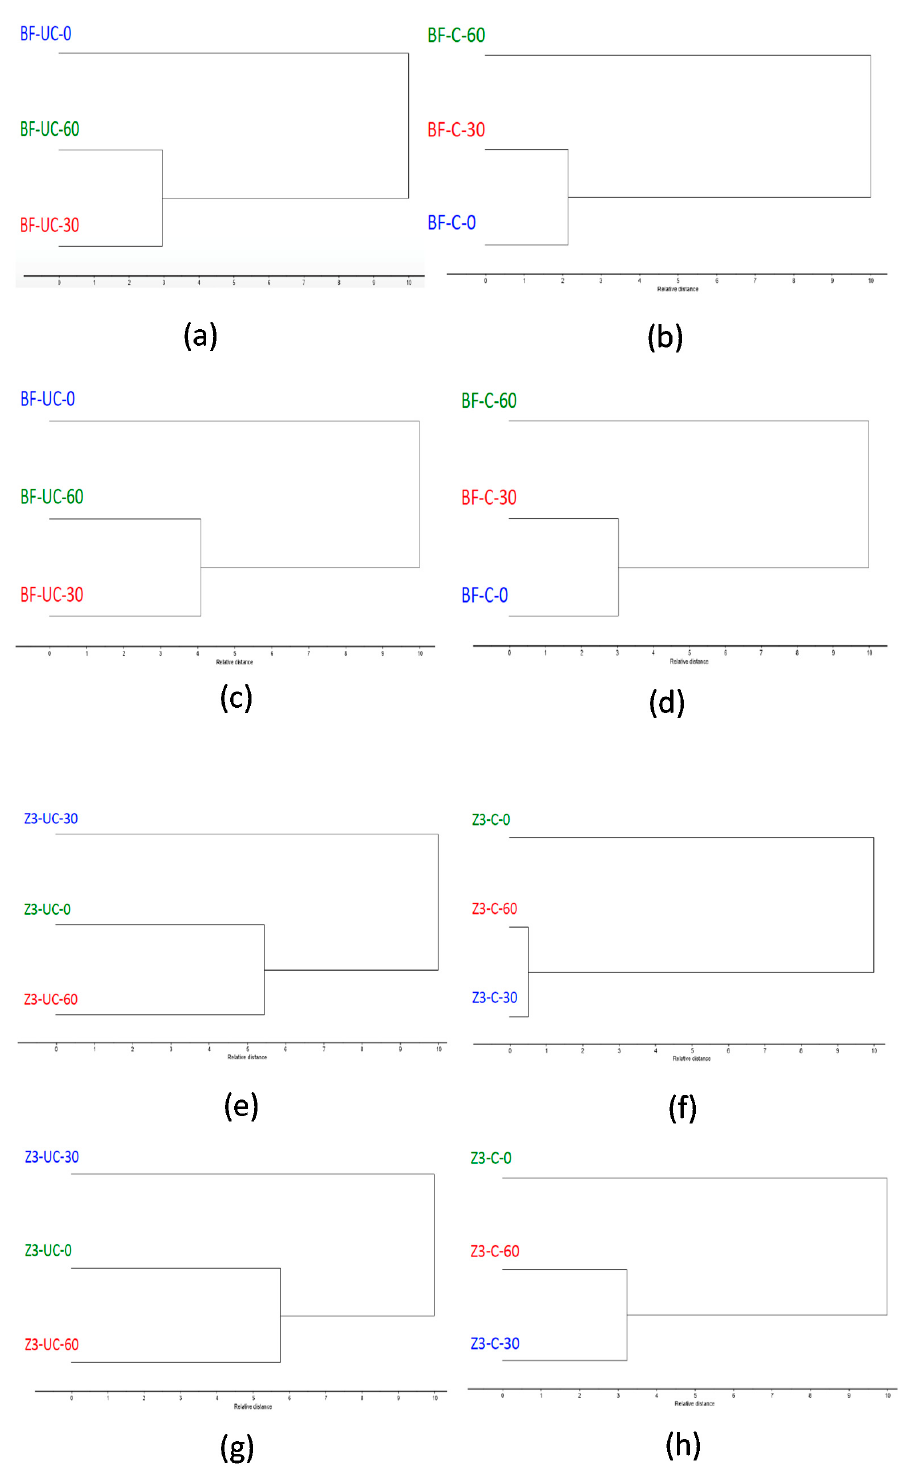
Figure 8. Cluster analysis of Filtek Bulk-fill composite showing uncured and cured at spectral range 1590–1650 cm − 1 ( a , b ), uncured and cured at spectral range 1700–1750 cm − 1 ( c , d ). Cluster analysis of Filtek Z350 composite showing uncured and cured at spectral range 1590–1650 cm − 1 ( e , f ), uncured and cured at spectral range 1700–1750 cm − 1 ( g , h ). At both the spectral ranges, there was a distinct separation without ultrasonic treatment from 30 s and 60 s while in the uncured state. However once cured, Filtek Bulk-fill showed that the control branched closer to the 30 s treated composite, whereby Filtek Z350 showed that the control was closer to both the 30 s and 60 s ultrasonic